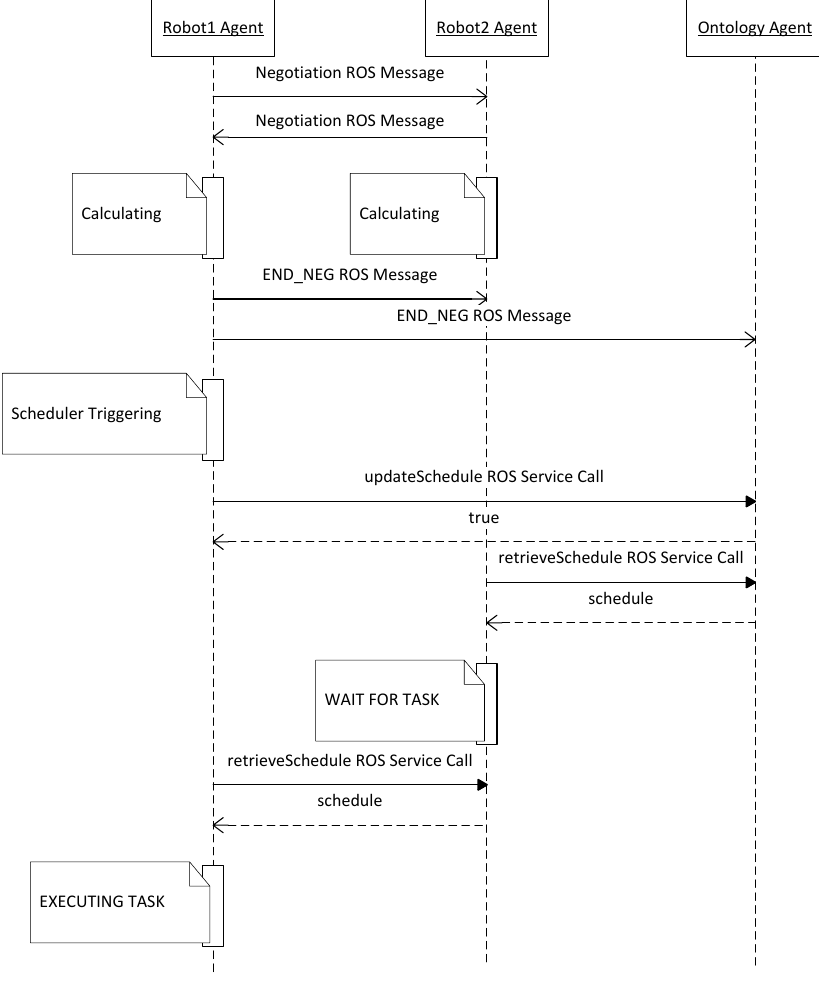
Figure 7. Negotiation mechanism.